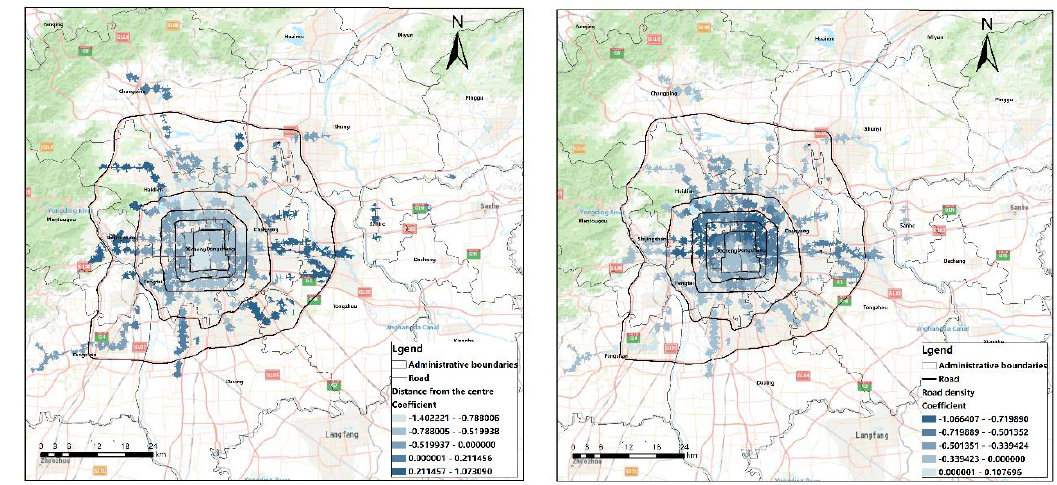
Figure 9. Spatial distribution of coefficients for MGWR.